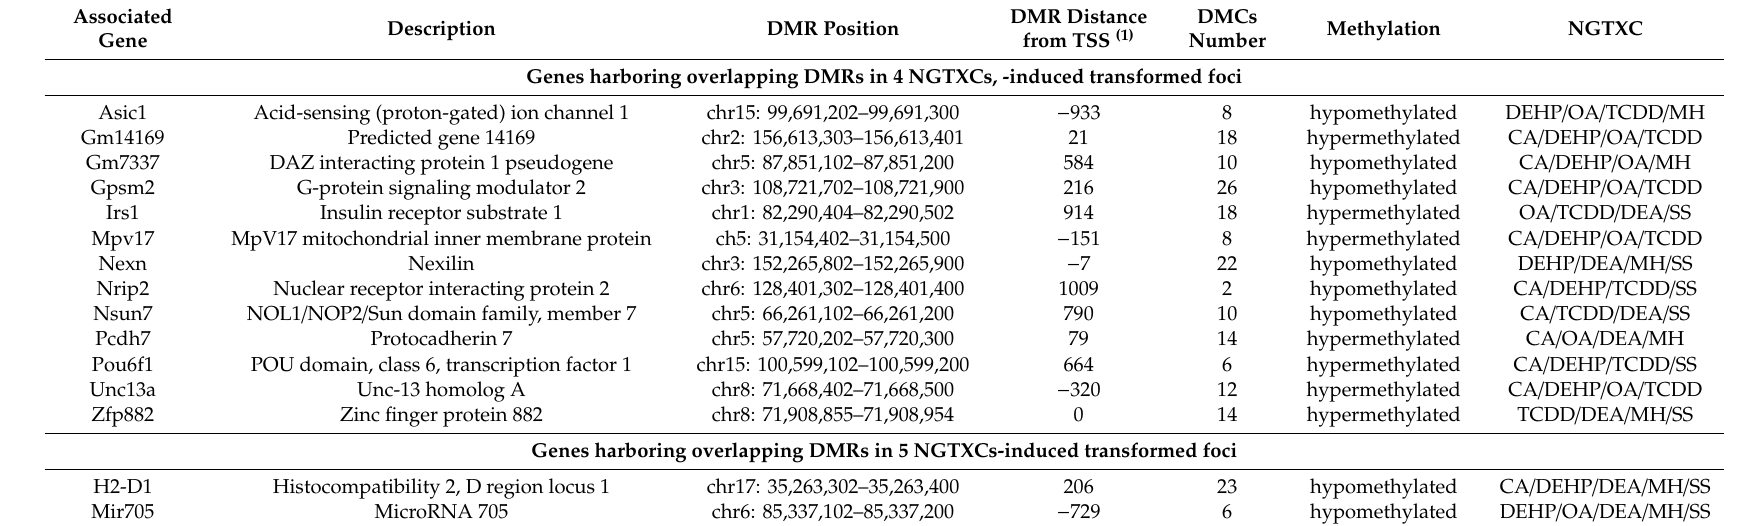
Table 4. Genes harboring the overlapping